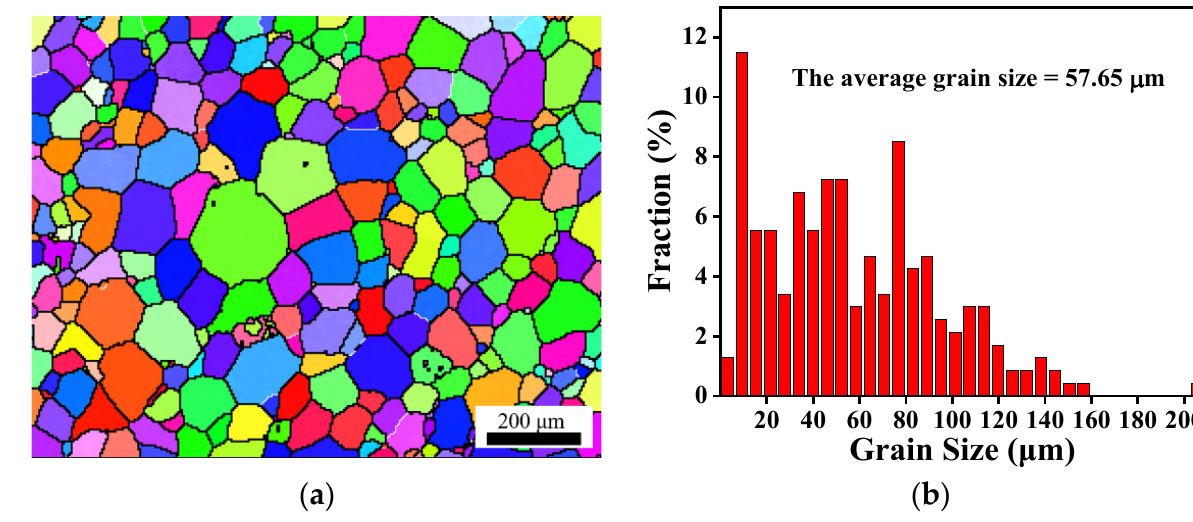
Figure 1. The EBSD micrograph of GW103K alloy before deformation ( a ) inverse pole figure (IPF); ( b ) statistical diagram of grain size.